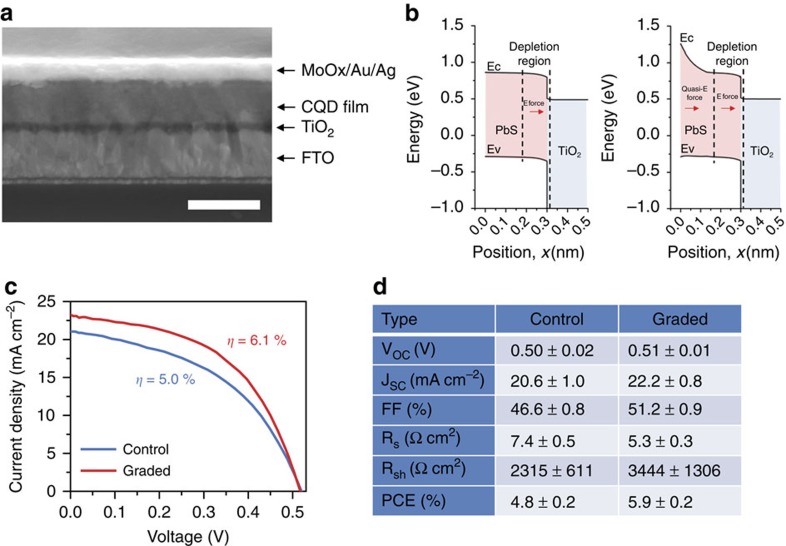
Photovoltaic cell performance of quantum-funnel CQD photodiodes.(a) A cross-sectional SEM image of a representative device. Scale bar, 500 nm. (b) Simulated spatial band diagrams of the ungraded control (left) and graded (right) devices operating at the maximum power point under AM 1.5 solar illumination. Band-bending near the rear of the device introduces a quasi-electric field capable of aiding carrier collection for improved performance. (c) Experimentally measured current–voltage characteristics under AM 1.5 simulated solar illumination for optimized devices employing ungraded control (blue) and graded (red) CQD devices. (d) Photovoltaic figures of merit of the devices cell under 100 mW cm−2 AM 1.5 illumination. Rs and Rsh are the series resistance and shunt resistance, respectively. Statistics for the devices are based on a total of >10 devices prepared on separate substrates.